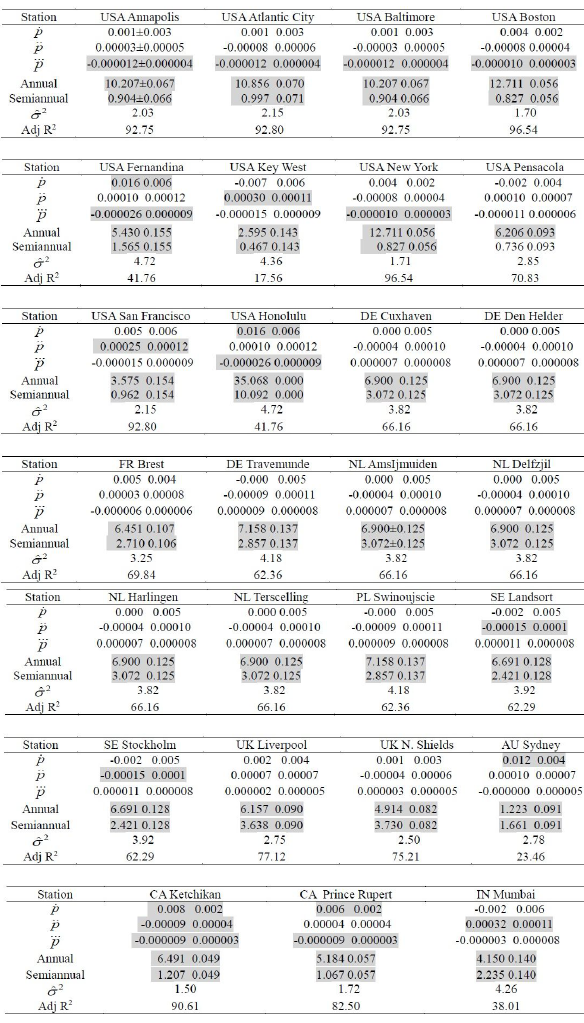
Table 1: The estimates for the atmospheric pressure model param- eters namely; trends, accelerations, change in the accelerations and the amplitudes of the periodicities calculated from their es- timated components, and their statistics. The amplitudes of the periodicities are in mb, which are followed by their standard devi- ations. Mean square error of the residuals (a posteriori variance of unit weight) is denoted by ^ σ 2 . Atmospheric pressure velocity esti- mates (trends) are in mb/yr. Statistically significant estimates are